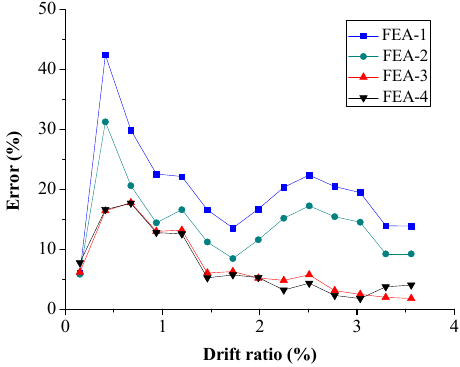
Figure 15. Root-mean-square error of cross-section moment.